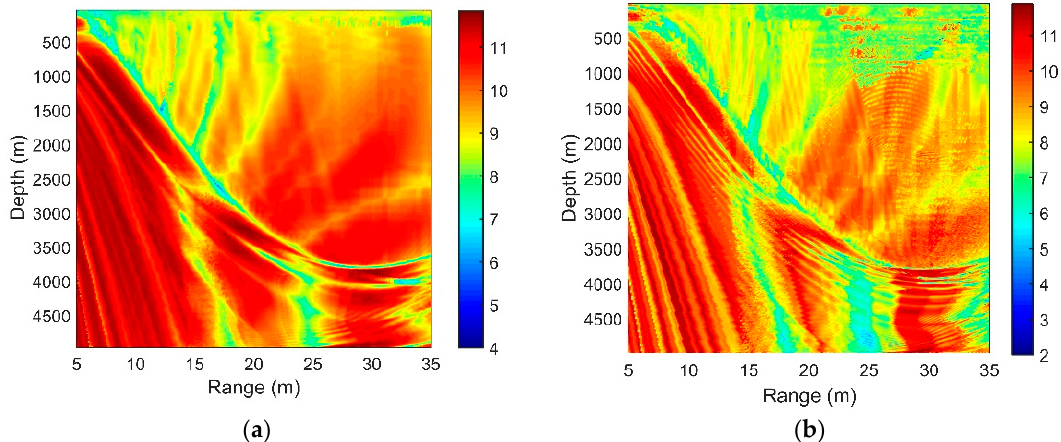
Figure 8. SG with different array locations for the center frequencies of ( a ) 150 Hz and ( b ) 450 Hz.